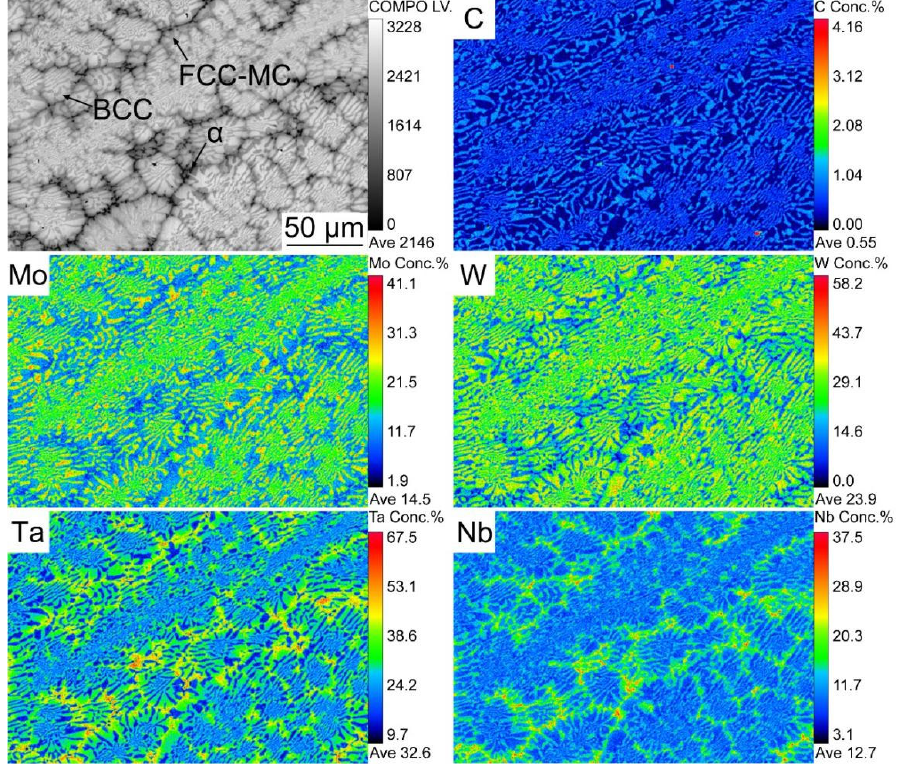
Figure 3. The map scanning images of MoNbTa(WC) 0.9 composite measured by EMPA. Table 2. The elemental composition of MoNbTa(WC) 0.9 The true compressive stress–strain curves of W0.7 and W0.9 at different temperatures were shown in Figure 4a,b. The resulting yield strength ( σ 0.2 ), compressive strength ( σ m ), and fracture strain ( ε ) were shown in Table 3. The fracture strain of W0.7 and W0.9 was 14.41% and 13.96%, respectively. The ductility of MoNbTa(WC) x has increased by about 10% with the addition of small-sized metalloid C compared with the fracture strain of MoNbTaW (about 3%). This might be attributed to grain boundary increment, and grain size reduction. Furthermore, the fine lamellar eutectic structures combined with the stiffer phase and ductile phase can prevent the propagation of cracks effectively. W0.7 and W0.9